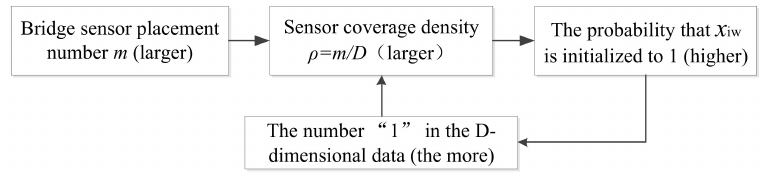
Figure 2. Features of DRCC